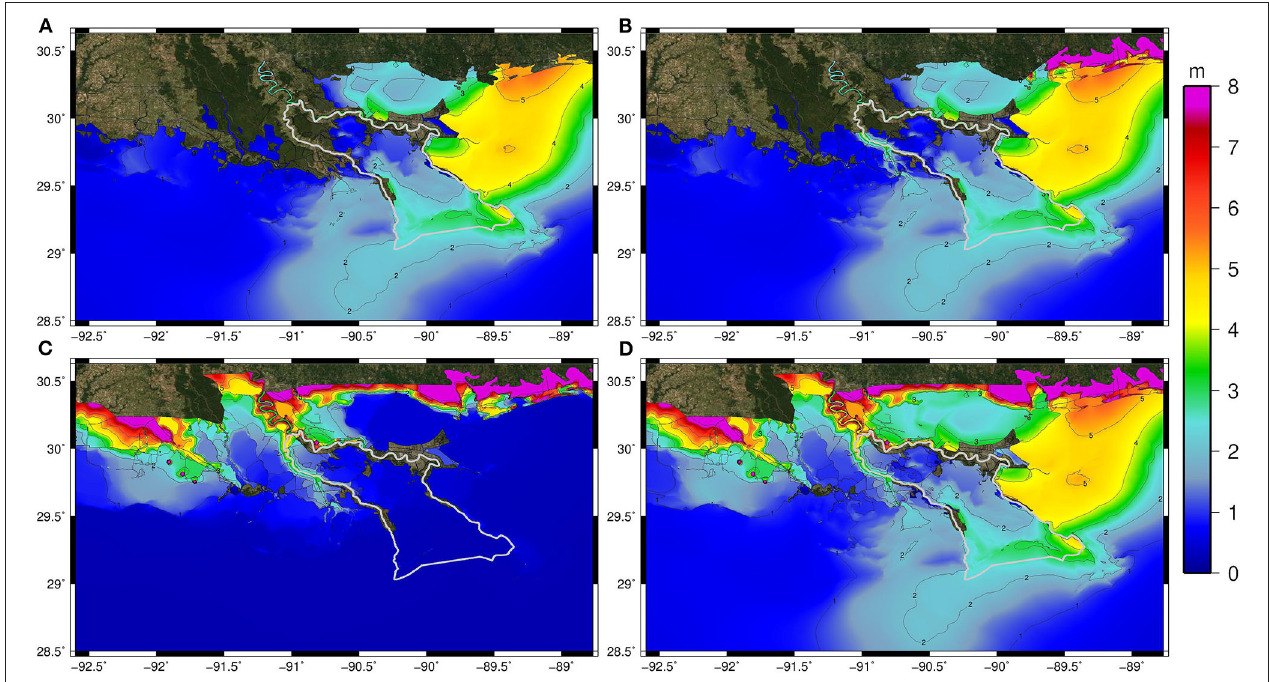
FIGURE 6 | Maximum of maximums (MOM) simulated peak water levels (m, NAVD88) for the Barataria watershed low event synthetic storms for (A) storm surge only (no rainfall), (B) storm surge and TC-driven rain, (C) antecedent rainfall only (no storm surge), and (D) antecedent rainfall, TC-driven rainfall, and storm surge in a single simulation.